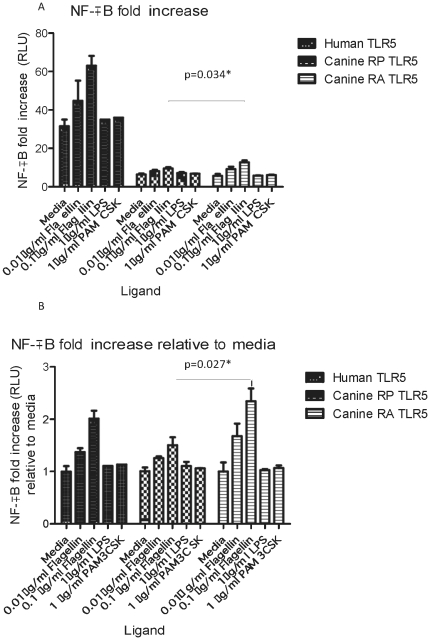
Activation of NF-κB in stimulated HEK 293 cells stably transfected with human TLR5, canineTLR5RP-YFP or canineTLR5RA-YFP.Transfected human TLR5, canineTLR5RP-YFP and canineTLR5RA-YFP HEK 293 cells were incubated with flagellin, PAM3CSK4, LPS or media for 24 hours before production of NF-κB was analysed by a luciferase reporter gene assay. The results displayed are the mean values of four independent experiments each with three repeats under the same conditions, with error bars illustrating standard error of the mean. Data are presented either as relative luciferase units (RLU) (A) or converted into fold-increase by comparing with RLU values obtained for unstimulated cells with media (B). There was a significant increase in the baseline and fold-increase in RLU values in canineTLR5RA-YFP compared to canineTLR5RP-YFP when the cells were stimulated with 0.1 µg/ml of flagellin (p = 0.034).